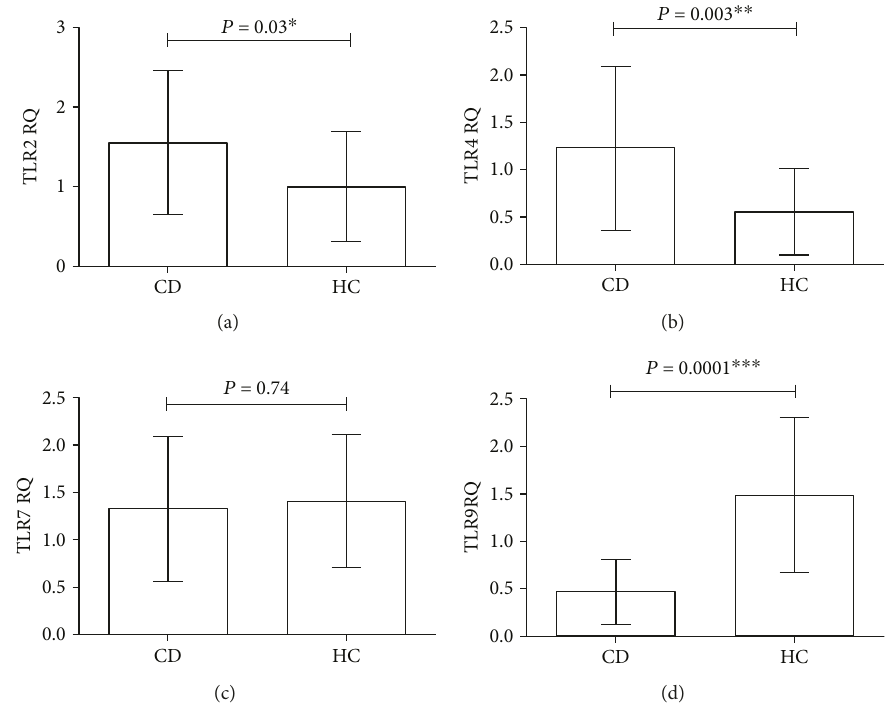
Figure 2: The relative expression of Toll-like receptors (TLRs) mRNA in small intestinal biopsies. Analysis of signi fi cance was performed by Student ’ s t -test. (a) TLR2, (b) TLR4, (c) TLR7, and (d): TLR9. ∗ , ∗∗ , ∗∗∗ P value is signi fi